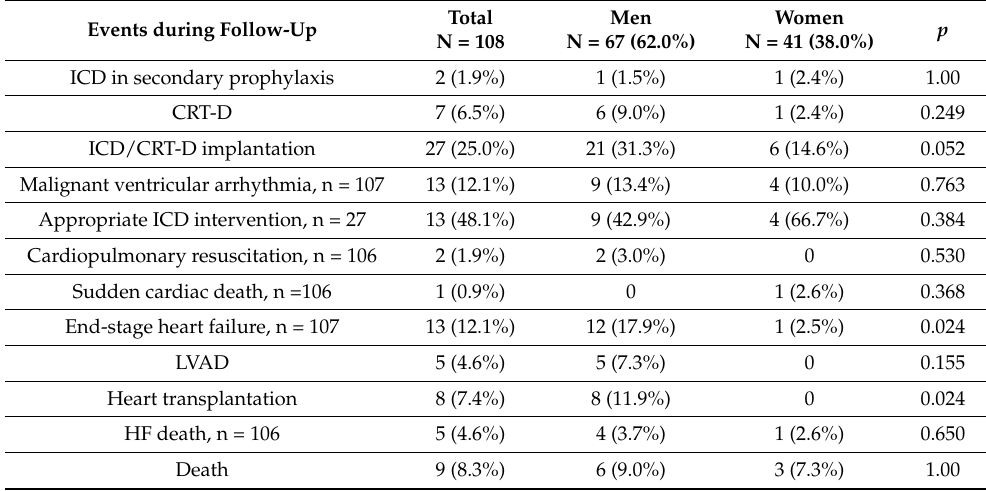
Table 2. Clinical outcomes in the cohort of TTN truncating variant